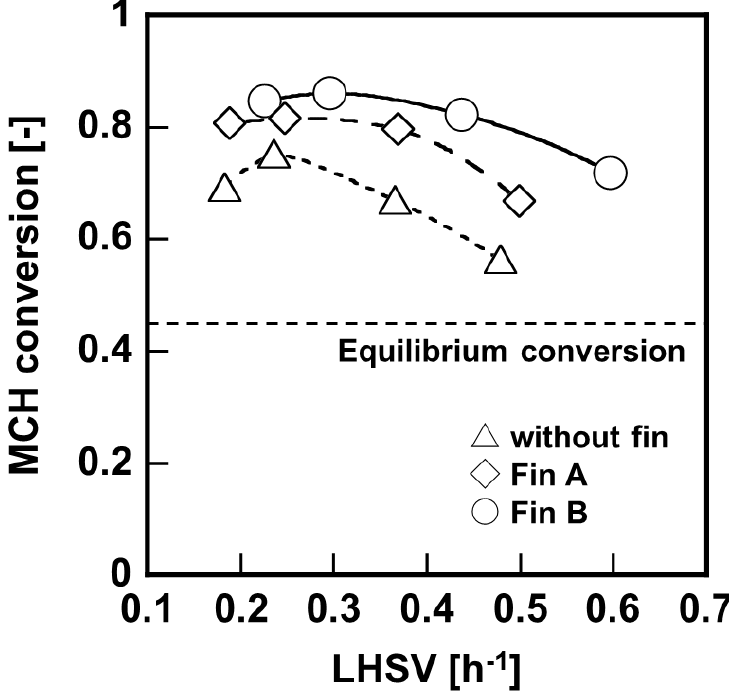
Figure 7. Comparison of MCH conversion using membrane reactor with different structure of heat conductive fins.